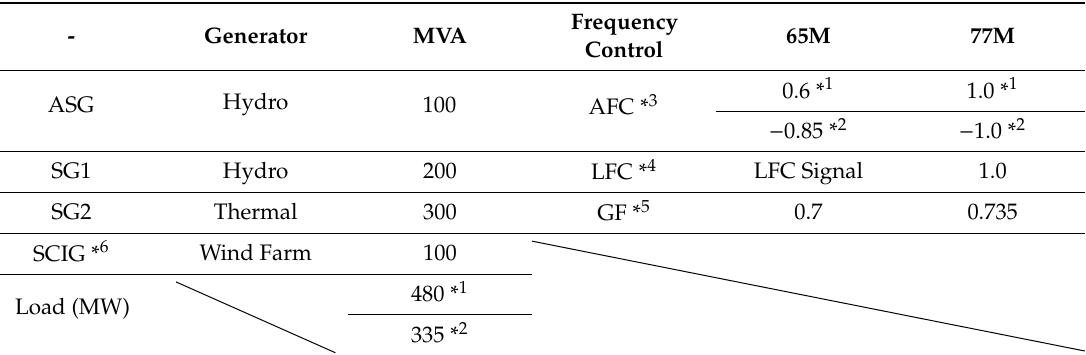
Figure 1. Model system. Table 1. Generator